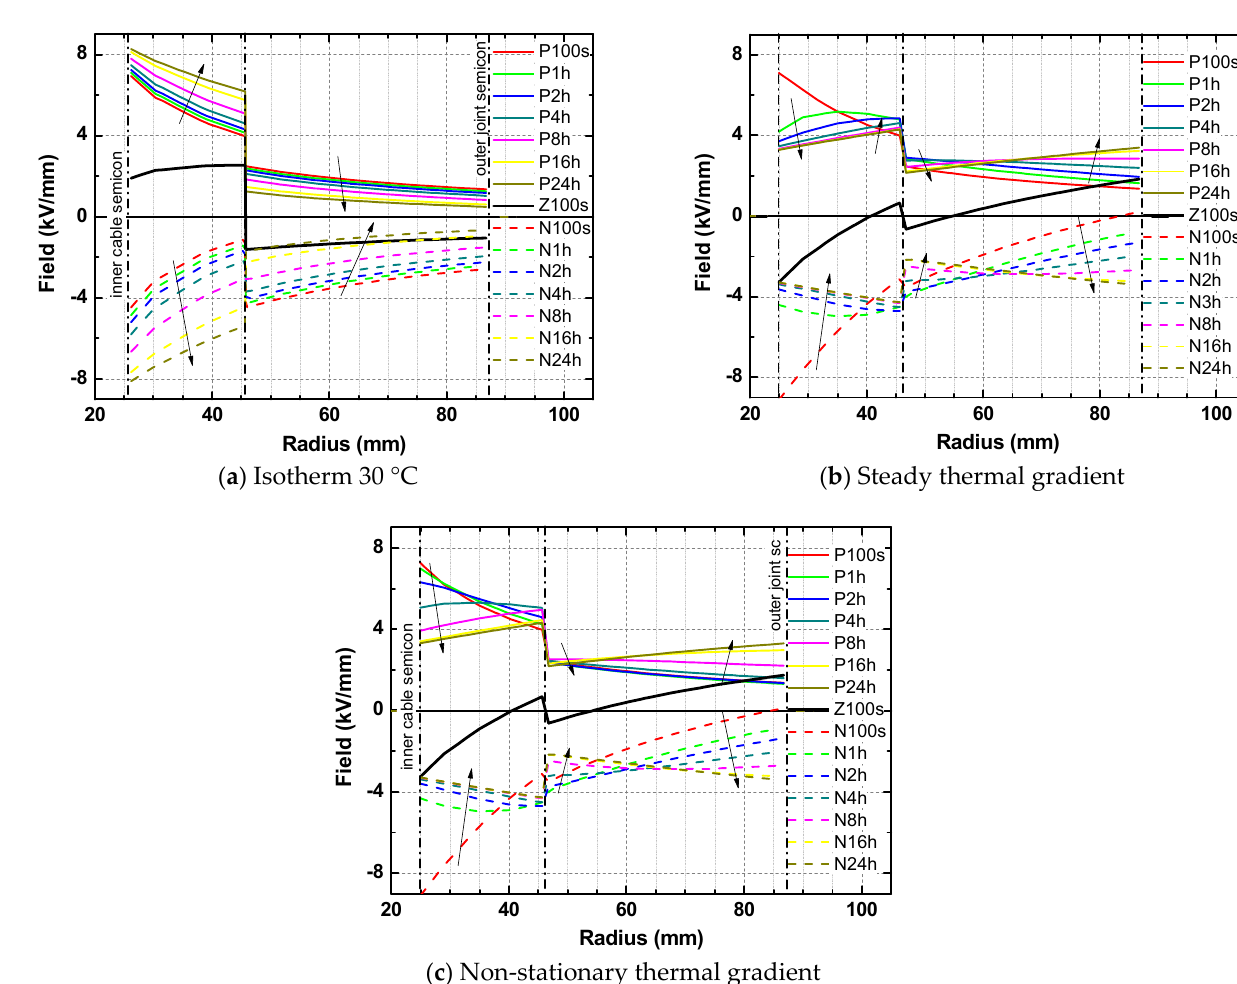
Figure 6. Radial field distribution in the XLPE/EPDM joint at different times after voltage application (+200 kV followed by polarity inversion) for different thermal conditions. Distribution taken at z = 800 mm, cf. Figure 3. Vertical lines indicate the boundaries of the insulators. The bold black curve corresponds to the reset to 0 V after 24 h at +200 kV. In the legend, P represents positive voltage; N for negative. The arrows provide a guide to the eyes for the variation of the field as a function of time.